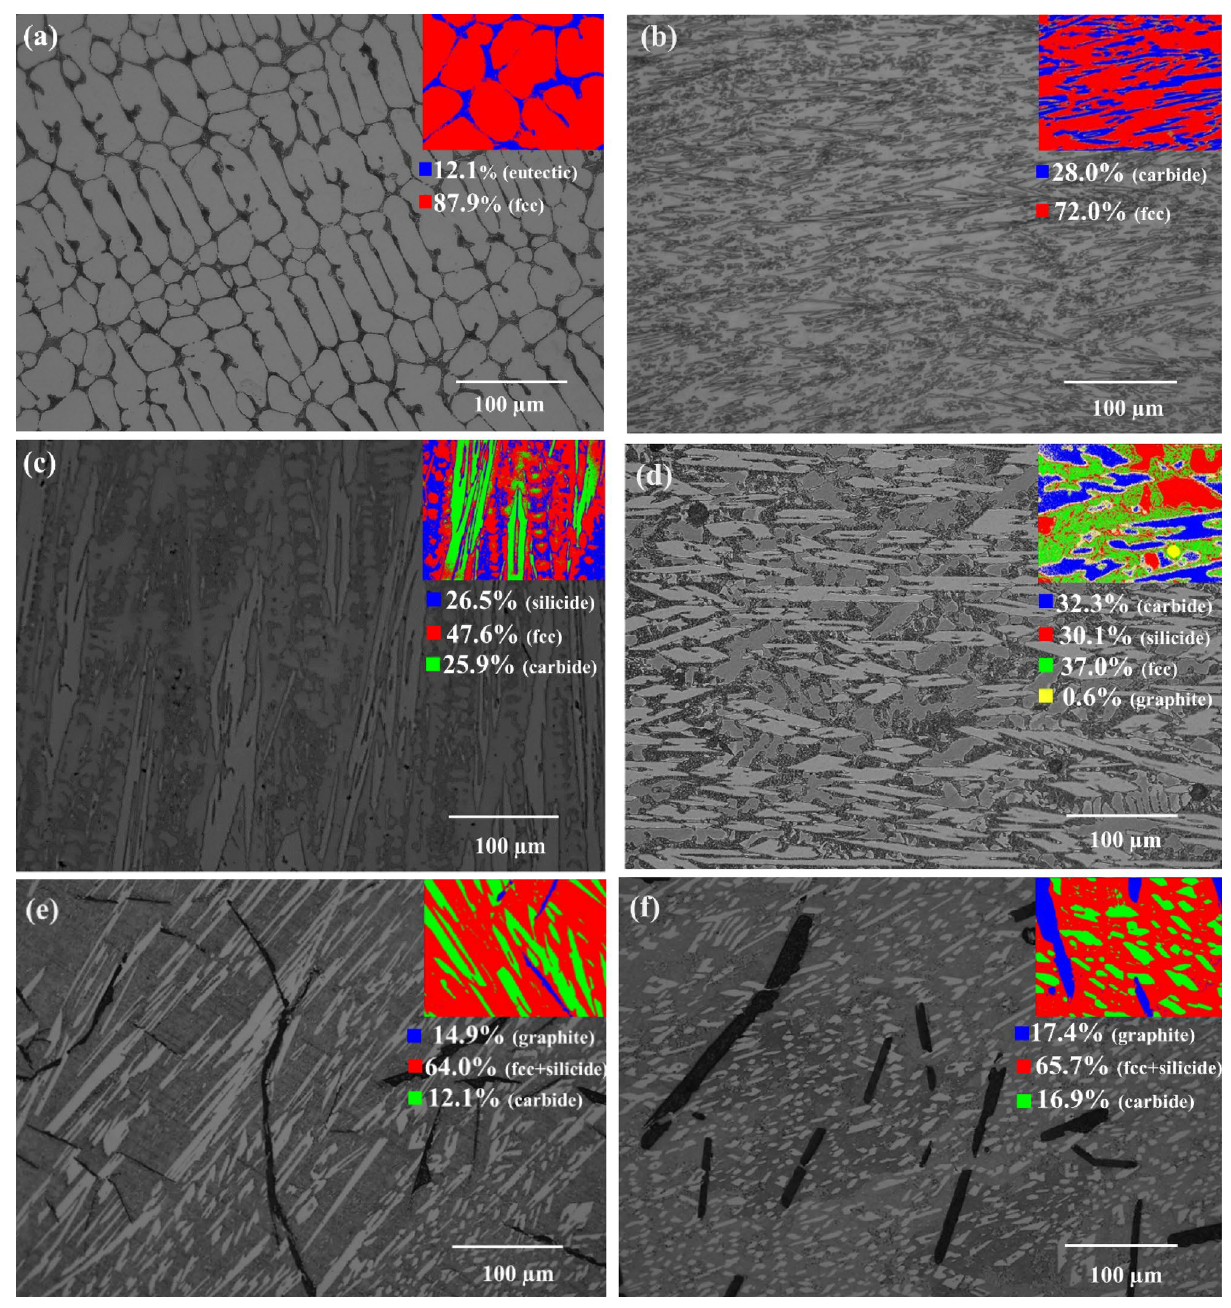
Figure 1. Optical micrographs of the as-developed high entropy composites: ( a ) S-1, ( b ) S-2, (c) S-3, ( d ) S-4, ( e ) S-5 and ( f ) S-6. The inset images show an example phase analysis results based on image contrast using the LAS Phase Expert